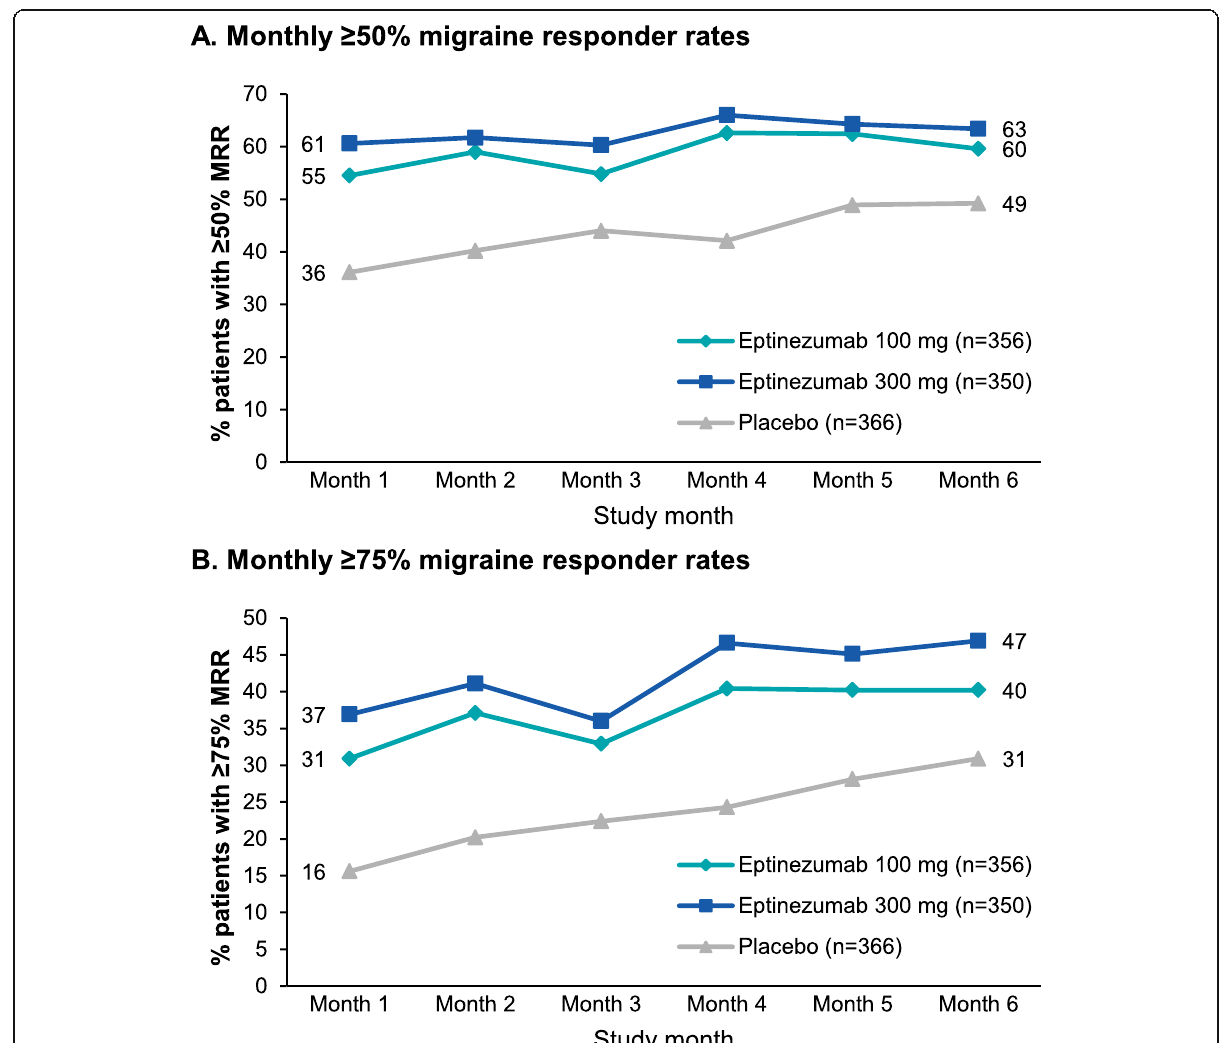
Fig. 1 Monthly migraine responder a rates: ( A ) ≥ 50% and ( B ) ≥ 75%. a Migraine response was defined as a reduction in monthly migraine days. MRR, migraine responder